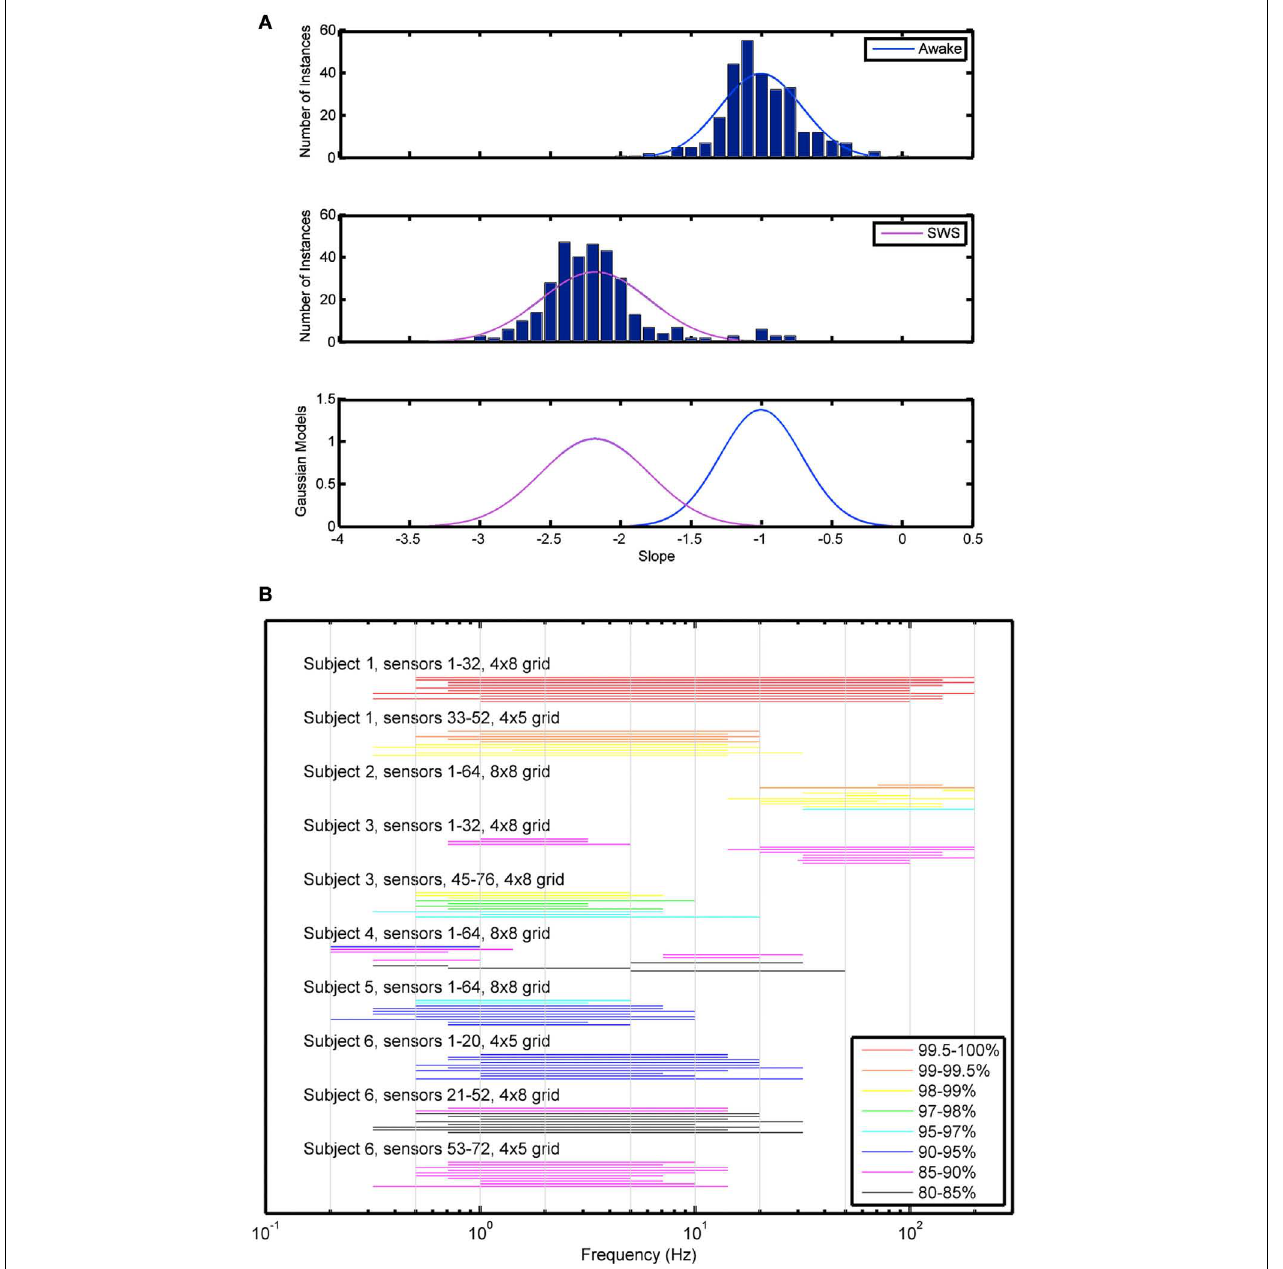
FIGURE 4 | Equal error state discriminator method. (A) Sample histogram demonstrating histogram data used for characterization of scale-free slope data. (B) EESD method showing the top 10 frequency ranges associated with best categorization between Awake and SWS states by grid and subject.